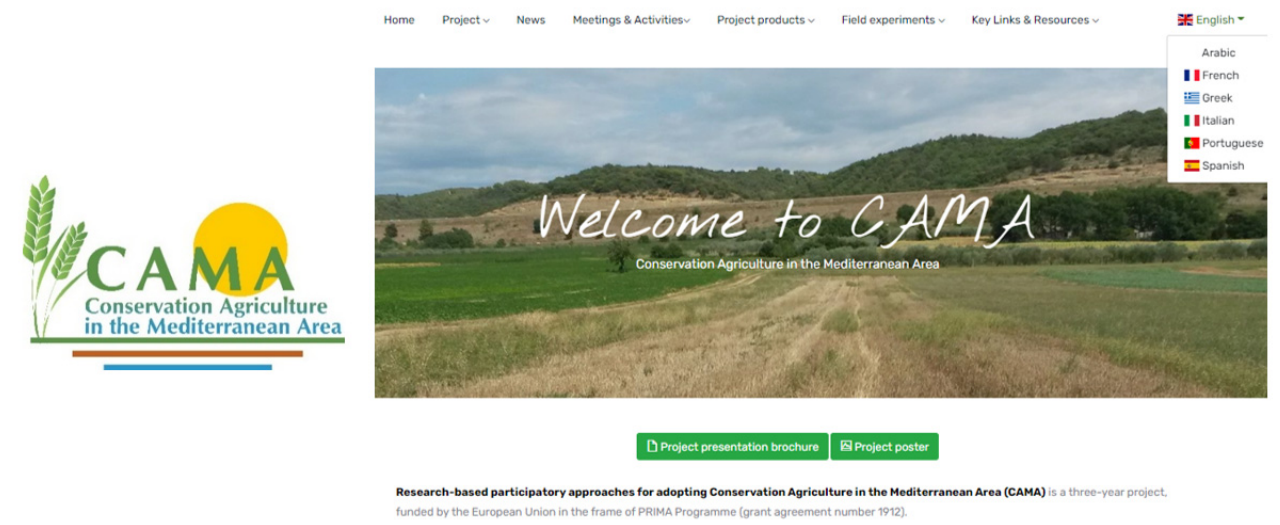
Figure 8. Logo and website of the CAMA project.